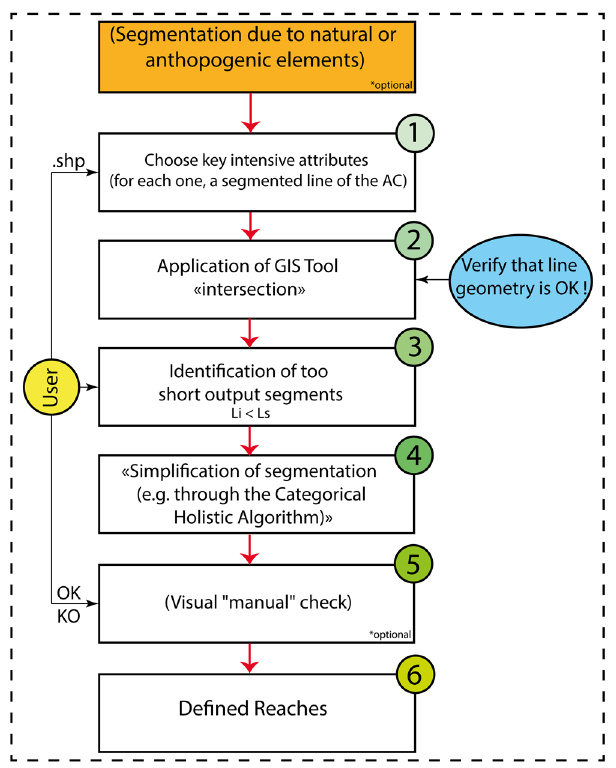
Figure 4. The proposed procedure to identify reaches. The necessary User’s input consists in choosing the attributes and the significant length Ls; the visual check is optional (and not included within an automatized procedure).